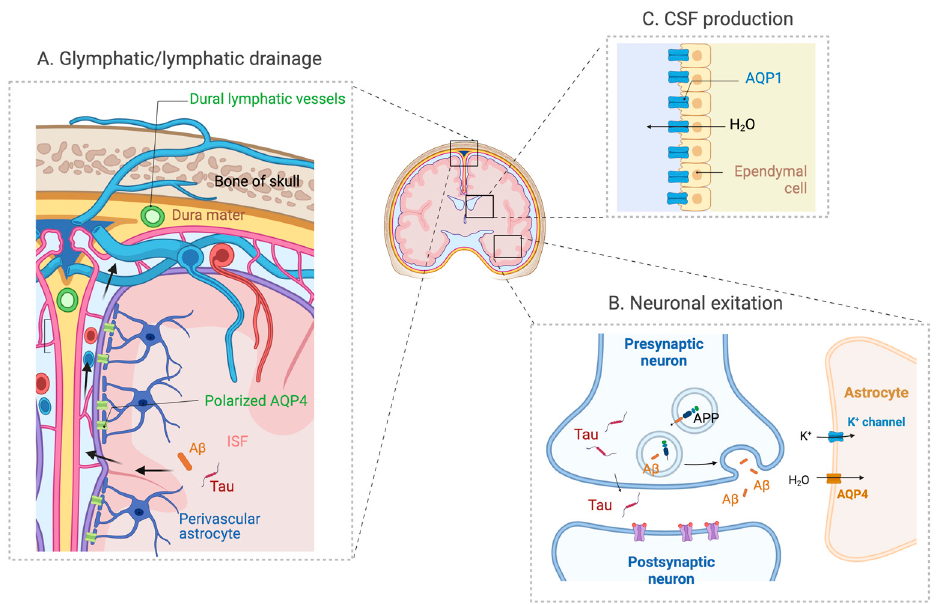
Figure 2. The expression and distribution of AQPs in the brain. ( A ) AQP4 expressed in perivascular astrocyte endfoot plays a significant role in the glymphatic system that drains A β and tau in ISF via the perivascular spaces. ( B ) AQP4 also has a role in neuronal excitation, and its deficiency may also impact the activity-dependent release of A β and tau. ( C ) AQP1 expressed in the choroid plexus has a role in CSF secretion (adapted from “Cranial meningeas”, “Tripartite Glutamatergic Synapse” and “Rodent Brain Subventricular Zone” by Biorender.com).